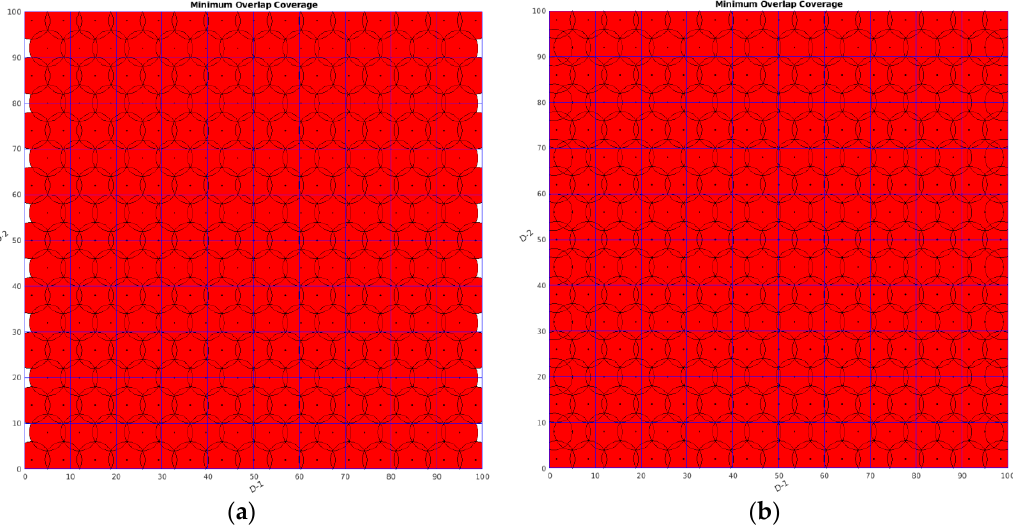
Figure 4. Here, rangemax = 100 and rangemin = 0, while the sensing radius of a single sensor is 4. The black point means a target location, the black circle means the sensing space boundary of a single sensor, and the red area means the whole sensing space of the wireless sensor network, while the very small white areas are vulnerabilities in monitoring. ( a ) The diagram without special treatment of the boundary and ( b ) with special treatment.